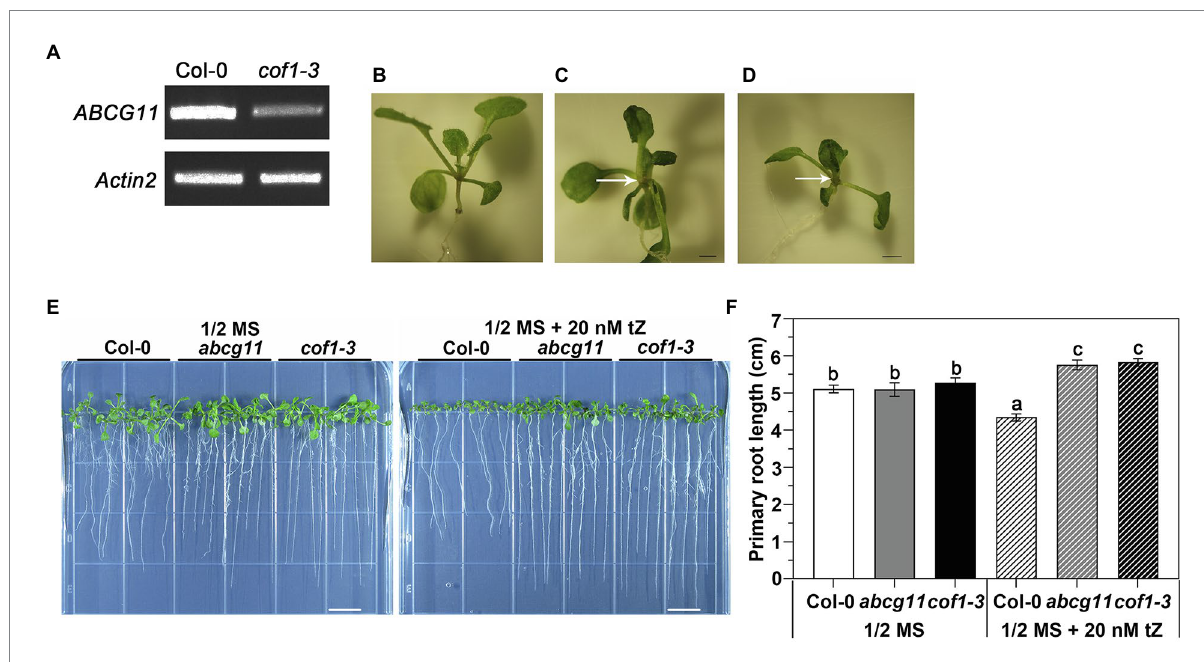
FIGURE 1 Second allele of abcg11 T-DNA insertion line cof1-3 (SALK_131624) exhibits an altered response to cytokinin, similar to abcg11 . (A) cof1-3 is a knockdown mutant of ABCG11 . RT-PCR analysis of AtABCG11 . Actin2 (At3g18780) was amplified as an internal control. The primers are listed in Supplementary Table S3. (B–D) Photographs of the shoots of 12-day-old seedlings of Col-0, abcg11 , and cof1-3 . The arrows point the sites of organ fusion. Scale bar = 1.0 mm. (E) The similar responses of cof1-3 and abcg11 roots to 20 nM trans -zeatin (tZ) treatment under long-day conditions (16 h/8 h, day/night). The photographs were taken at 12 days after seed sowing. The photos are representatives of four independent experiments. Scale bars = 1 cm. (F) The average primary root length of the plants shown in (E) . The error bars represent the standard error (SE; n = 40). The different letters indicate the significant differences determined by one-way ANOVA ( p <